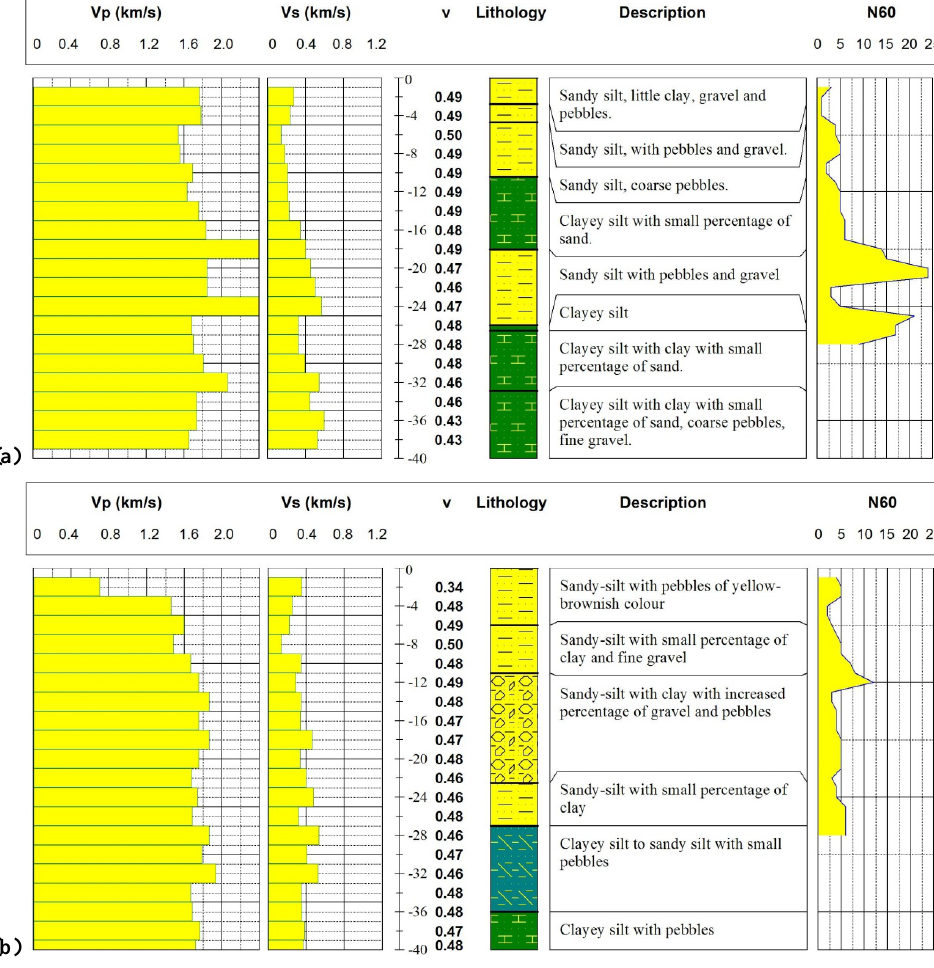
Fig. 7. Example of soil profiles at borehole testing sites G1 (a) and G2 (b) . Nevertheless, the main reason for conducting the passive survey was to investigate the 1-D shear wave velocity at an old 100 m deep borehole (site 3042 on the map of Fig.